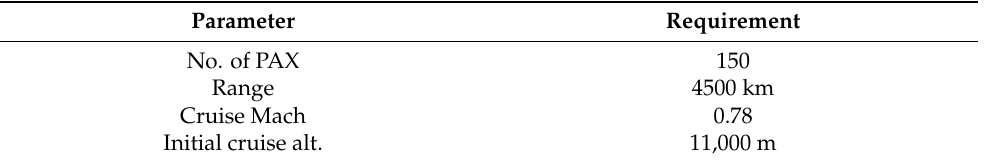
Table 1. Top-Level Aircraft Requirements (TLAR) for SE 2 A mid-range